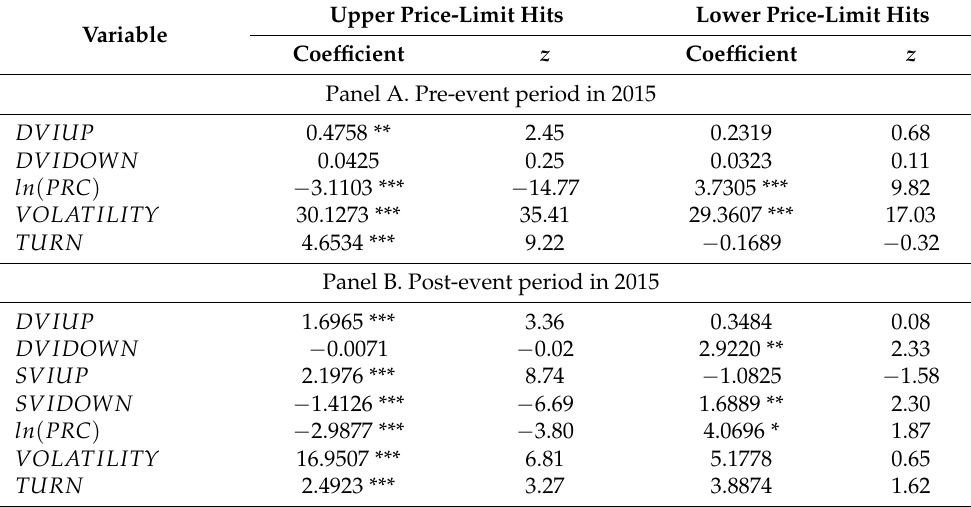
Table 6. Panel logit analysis. This table provides estimation results for a panel logit regression model (Equation (4)). Panels A and B show the results for the pre- and post-event periods in 2015, respectively. Dependent variables are either upper or lower price-limit hits, which are the binary variable having the value of 1 if the stock i at time t experiences a hit on either upper or lower price limit, or 0 otherwise. DVIUP it ( DVIDOWN it ) is the number of increasing (decreasing) dynamic VIs that the stock i experiences at time t . SVIUP it ( SVIDOWN it ) is the number of increasing (decreasing) static VIs that the stock i experiences at time t . For control variables, we include the stock price ( ln ( PRC it ) ), intraday volatility ( VOLATILITY it ), and turnover ( TURN it ). *, **, and *** denote 10%, 5%, and 1% statistical significance, respectively. Upper Price-Limit Hits Lower Price-Limit